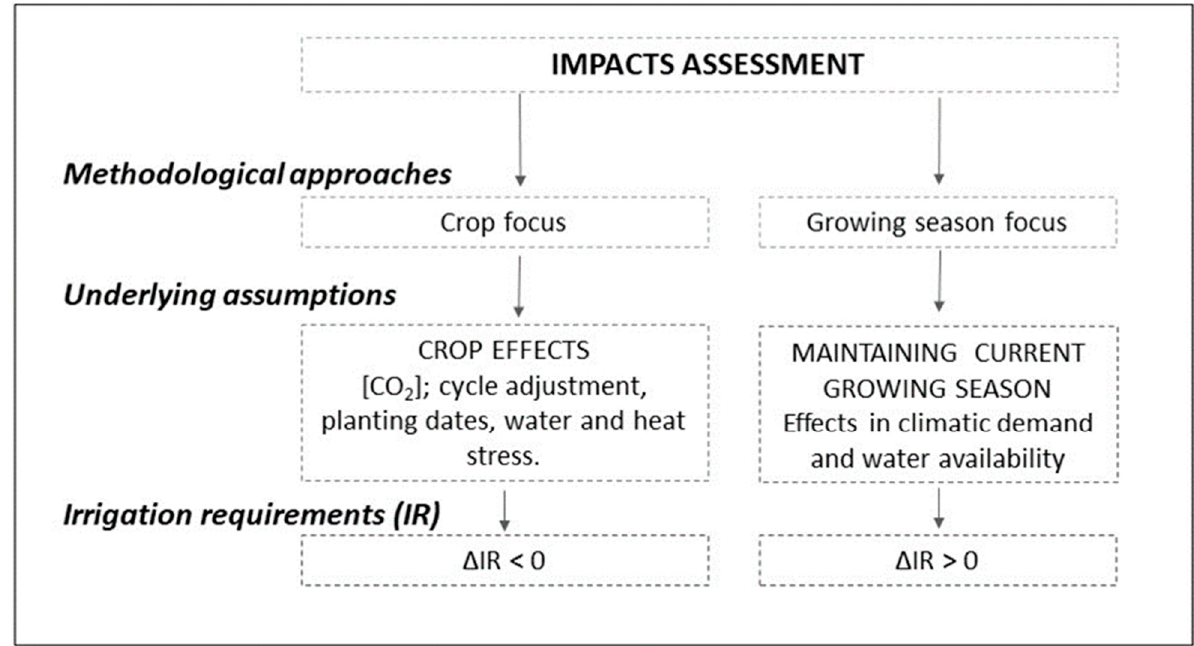
Figure 2. The most common methodological approaches to obtain CC impacts on irrigation requirements.